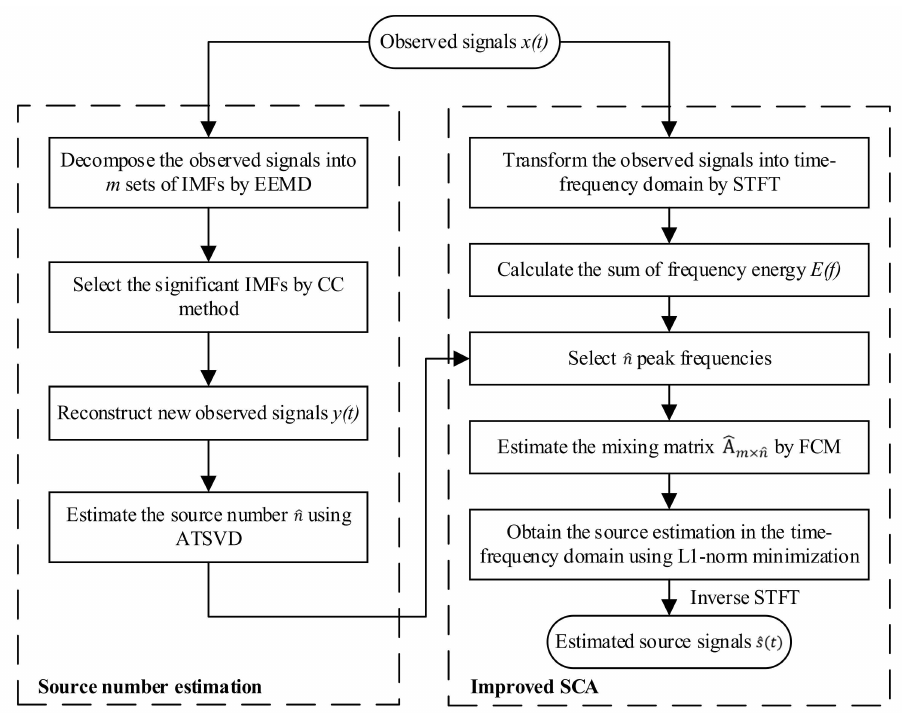
Figure 3. The flowchart of the proposed UBSS